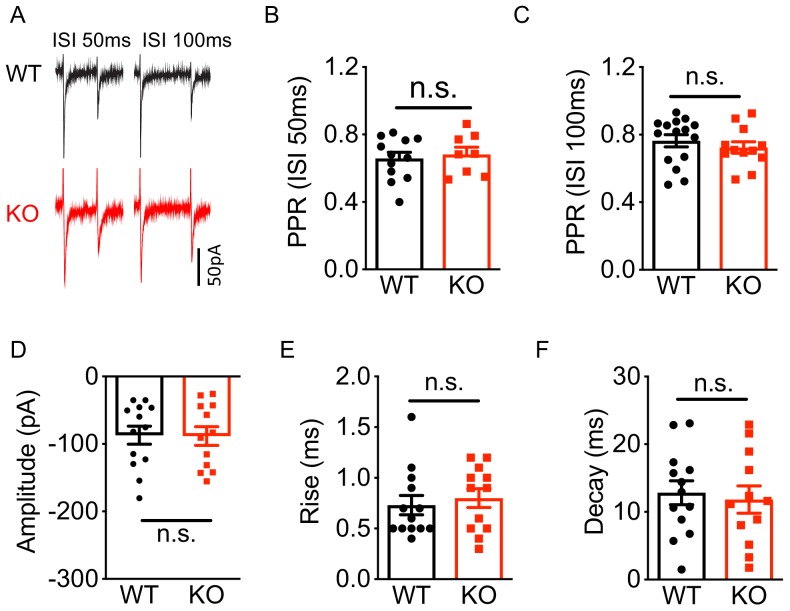
Deletion of Nxph4 KO did not affect mossy fibers-granule cell EPSC.(A) Sample traces of granule cell EPSC, evoked by stimulating mossy fibers, exhibited paired-pulse depression at ISI (inter-stimulus interval) 50 ms and ISI 100 ms from WT and KO mice. (B–F) Summary of eEPSC paired-pulse ratio (EPSC2/EPSC1, PPR) at ISI 50 ms and ISI 100 ms, amplitude, rise time, and decay (n = 5–7 mice). Data are presented as mean ± SEM. n.s., not significant; by Mann-Whitney U test or t-test.